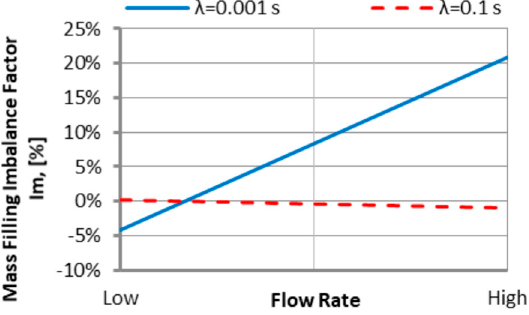
Figure 13. An effect of the relaxation time λ on the mass filling imbalance factor I m at various injection rates (Low = 5 cm 3 /s, High = 500 cm 3 /s).